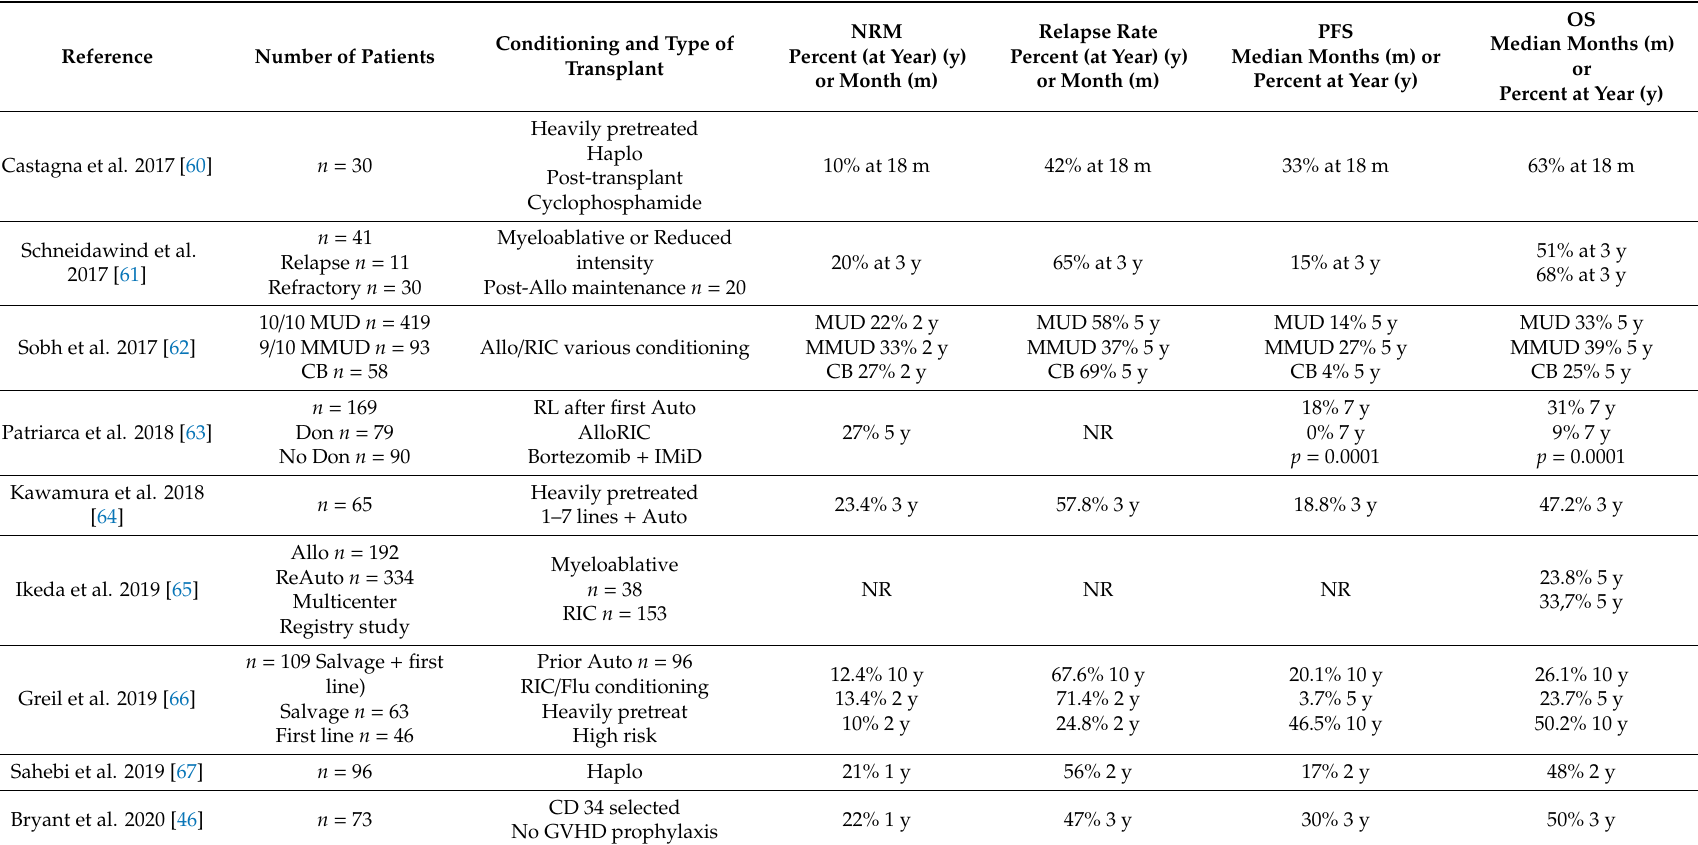
Table 3. Studies from 2017 of allogeneic transplantation in relapsed and / or refractory multiple myeloma patients